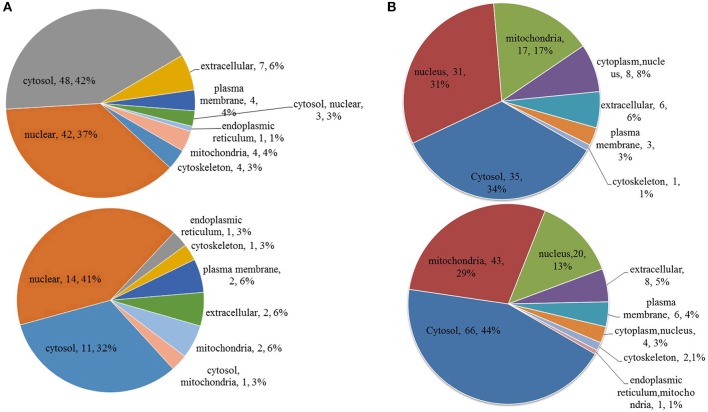
Subcellular location of differentially phosphorylated and acetylated proteins. (A) phosphorylation. (B) acetylation. Up, subcellular location of proteins for which the modification was upregulated. Down, subcellular location of proteins for which the modification was downregulated.